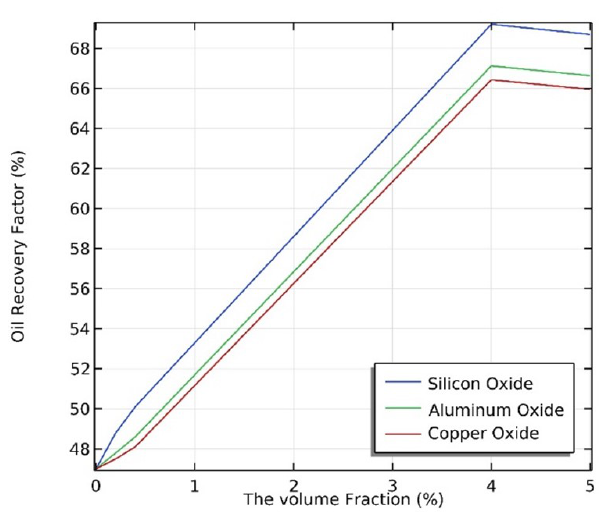
Figure 16. The effect of nanoparticle VFs on